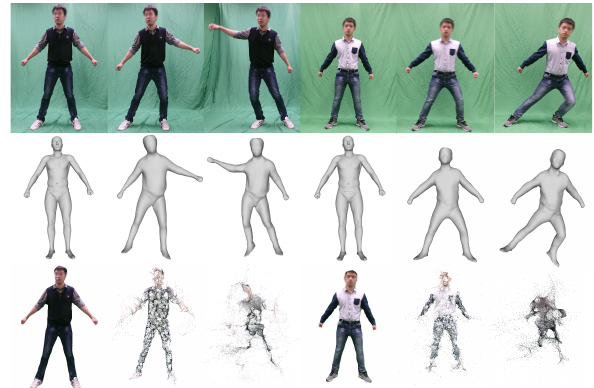
Figure 11. Results from two different motion sequences. The middle row is some of the results from our template corresponding to frames of the motion sequences shown in the first row. The last row shows the template required by Yu’s algorithm [21] and some of the results obtained through their